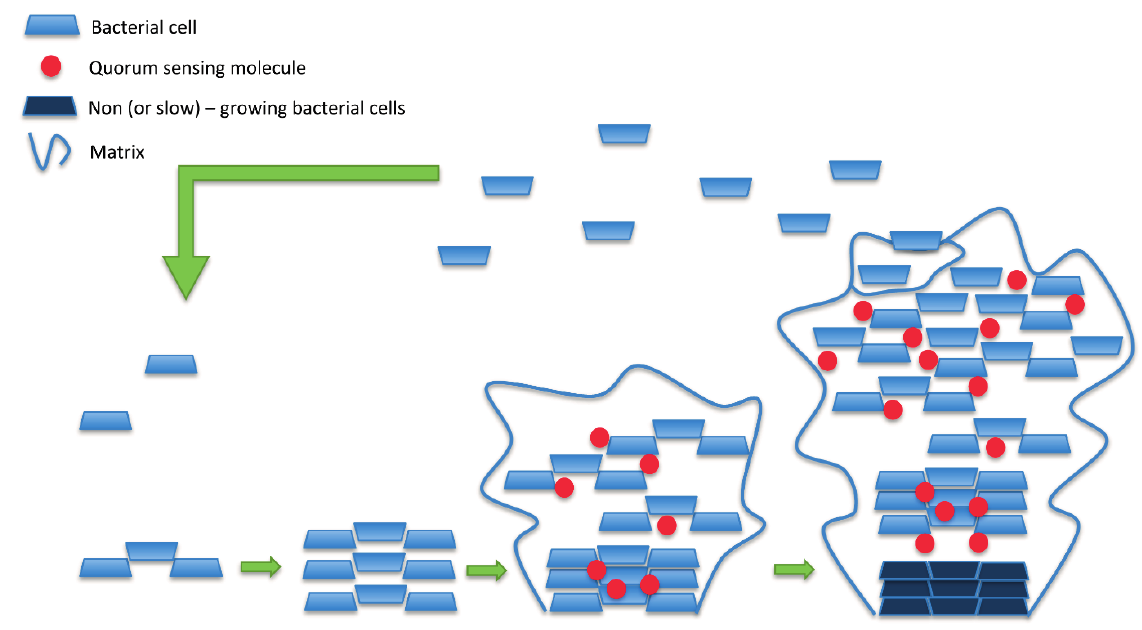
Figure 3. Planktonic cells adhere to the surface and proliferate. During biofilm maturation, the extracellular matrix and quorum sensing molecules are produced. Mature biofilms are generally characterized by an increased abundance of matrix materials, slow-growing bacterial cells in the centre, and fragmentation which leads to cell detachment and spread of